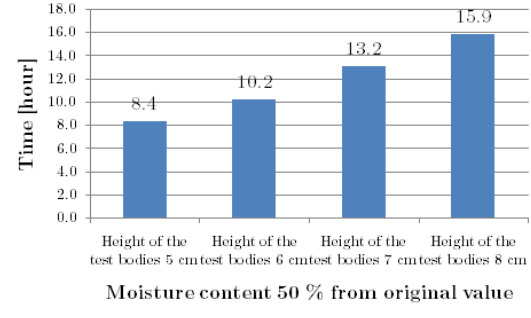
Figure 12. The decrease by 50 % from original value of the moisture